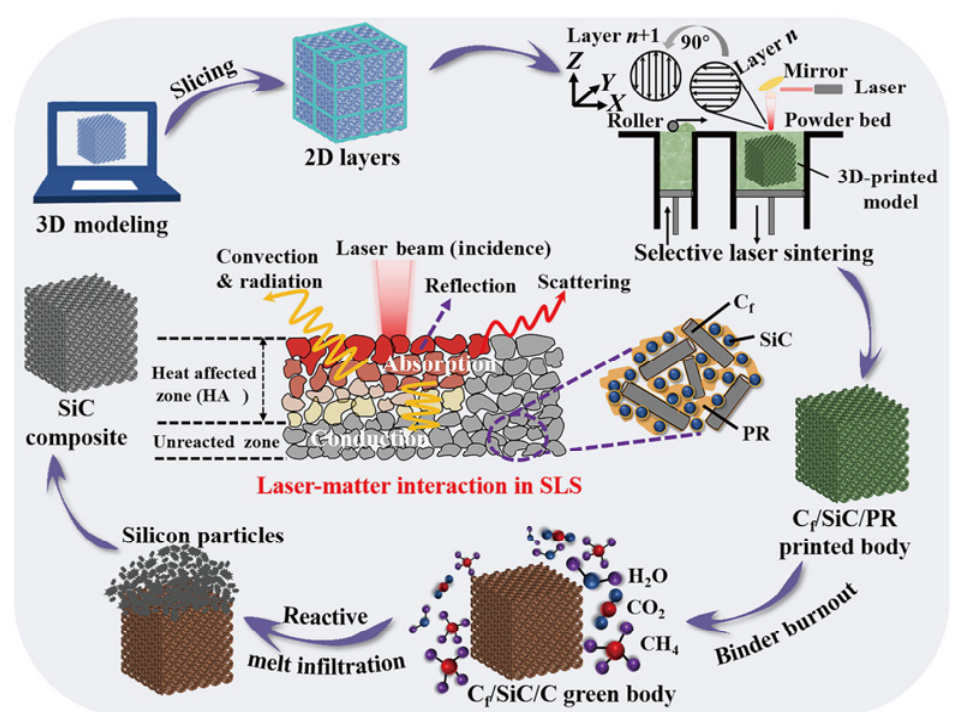
Fig. 2 Schematic diagram of the fabrication of SiC